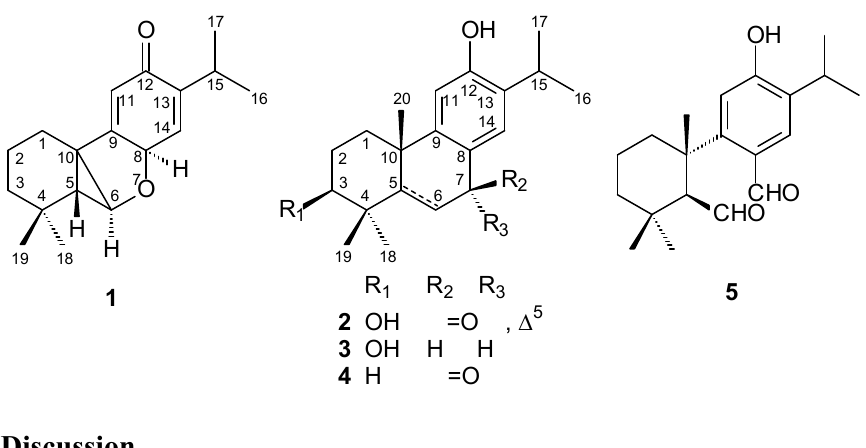
Figure 1. The chemical structures of compounds 1 – 5